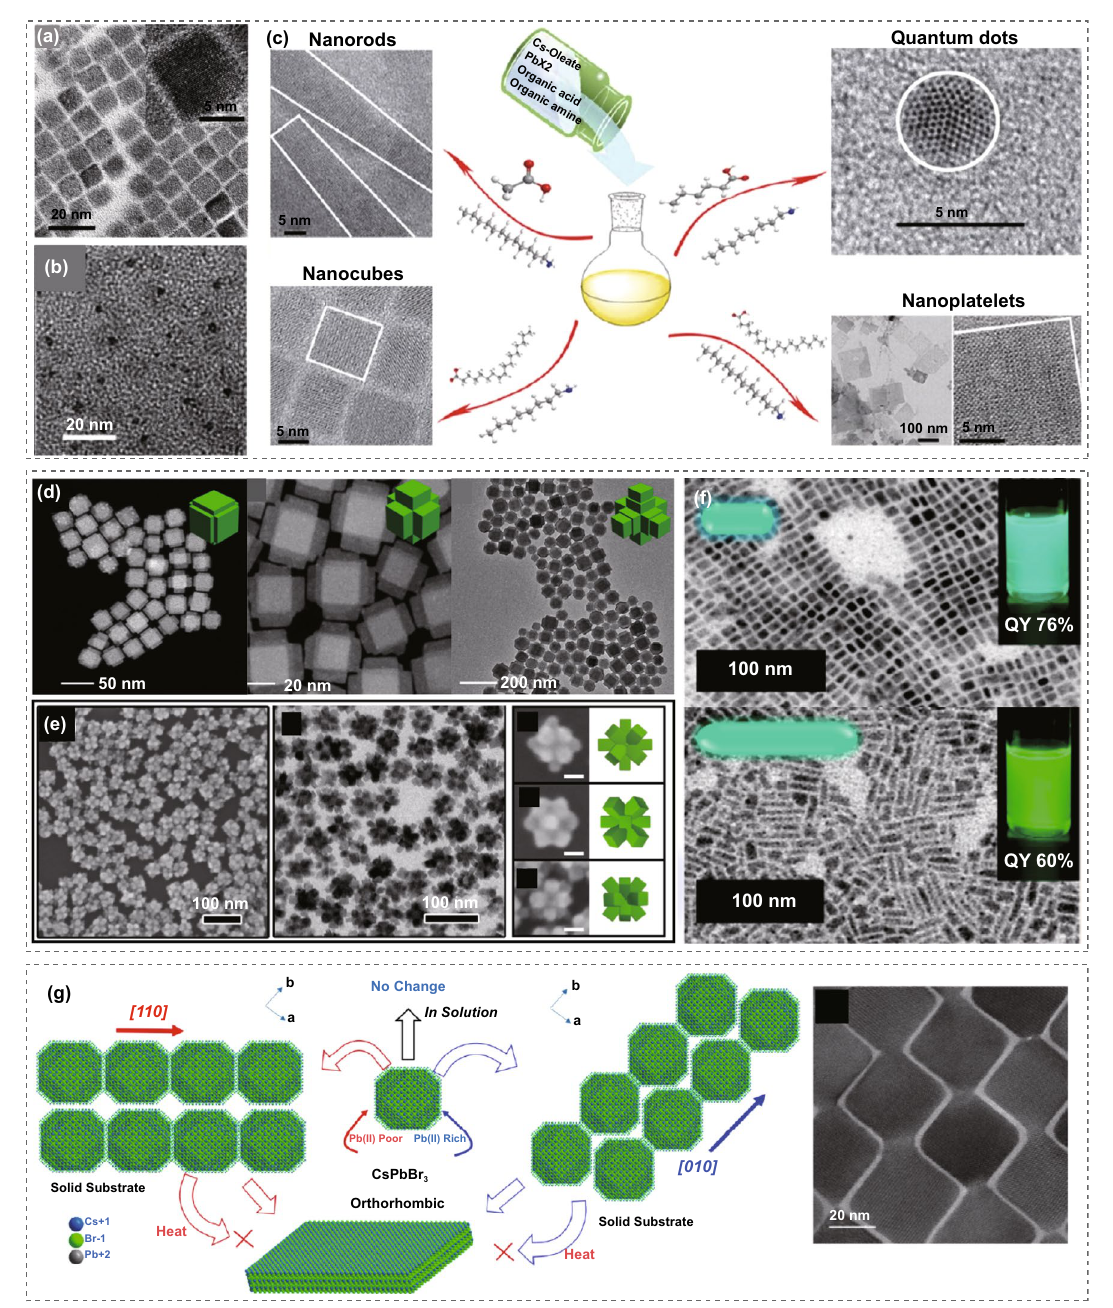
Fig. 4 a Transmission electron microscopy (TEM) image of cuboid CsPbBr 3 QDs. Adapted with permission from Ref. [96]. Copyright 2016, Wiley–VCH. b TEM images of CsPbBr 3 nanospheres. Adapted with permission from Ref. [126]. Copyright 2016, American Chemistry Society. c Schematic diagram of different morphologies of inorganic perovskite nanocrystals produced by varying the ligands. Adapted with permission from Ref. [127]. Copyright 2016, American Chemistry Society d TEM of CsPbBr 3 and CsPbI 3 nanocrystals formed under different reaction temperatures. Adapted with permission from Ref. [107]. Copyright 2019, American Chemistry Society. e Scanning electron microscope (SEM) and TEM image of CsPbBr 3 dodecapods nanoflowers. Adapted with permission from Ref. [106]. Copyright 2018, Elsevier Publishing. f SEM image of CsPbBr 3 nanorods formed by tip sonification. Adapted with permission from Ref. [128]. Copyright 2019, American Chemistry Society. g Schematic diagram of directional connection of CsPbBr 3 QDs. Adapted with permission from Ref. [129]. Copyright 2020, American Chemis- try